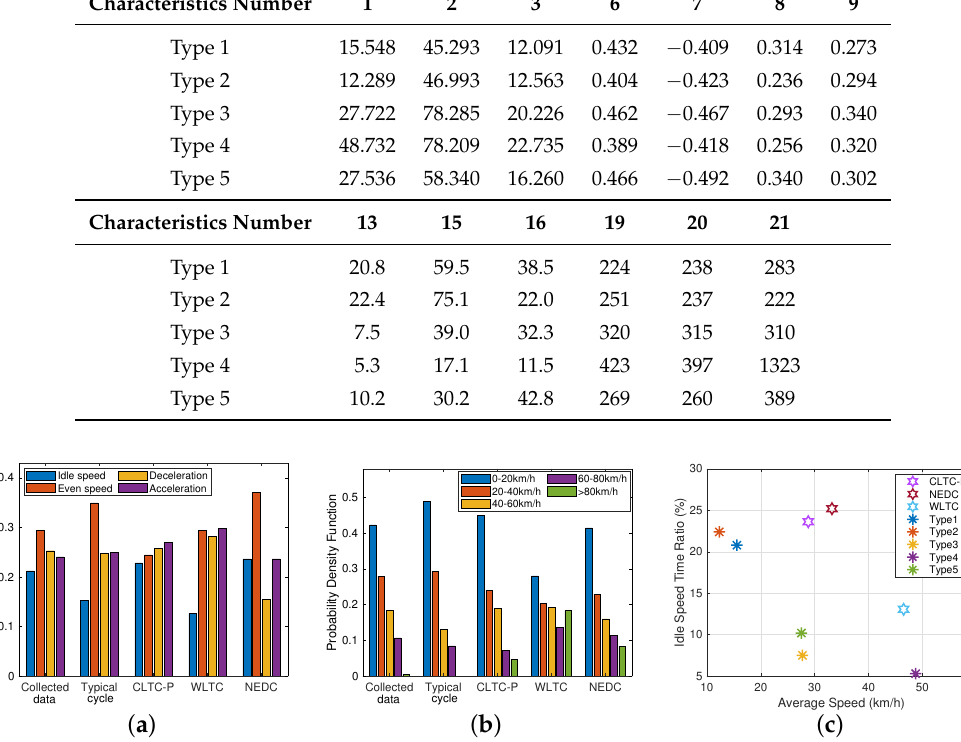
Figure 11. Comparison between typical driving cycles for a specific driver and existing driving cycles: ( a ) probability density function of phase. ( b ) Probability density function of speed. ( c ) Scatter plot of the average speed and idle speed time